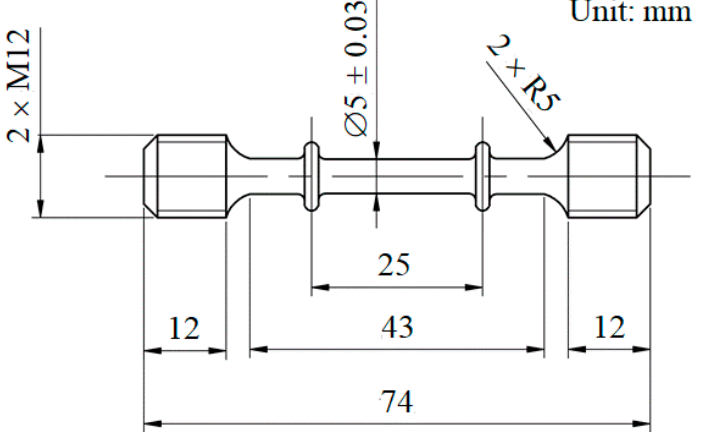
Figure 3. Dimensions of tensile creep specimens.